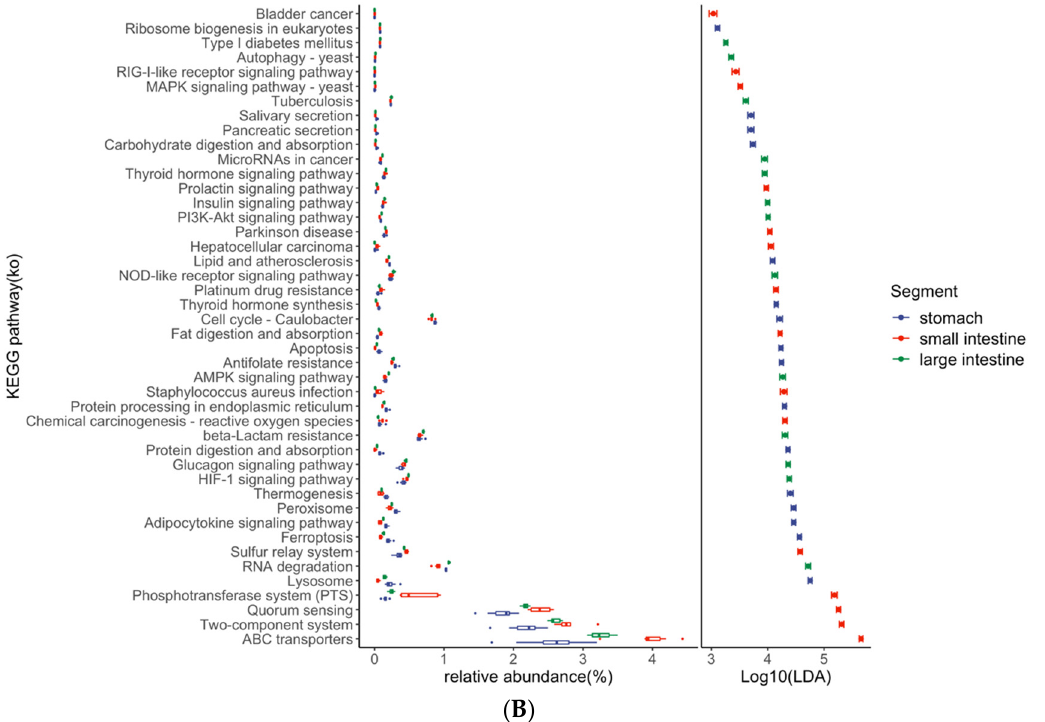
Figure 4. Characteristic KEGG pathways of the stomach, small intestine, and large intestine. ( A ) Heatmap of differentially enriched pathways related to the metabolism. The relative abundance of pathways was transformed into a Z-score, and second level categories of KEGG pathways are annotated with discrete colors in the left bar of the plot. ( B ) The relative abundance and logarithmic LDA score of characteristic KEGG pathways in other first level categories, rather than in